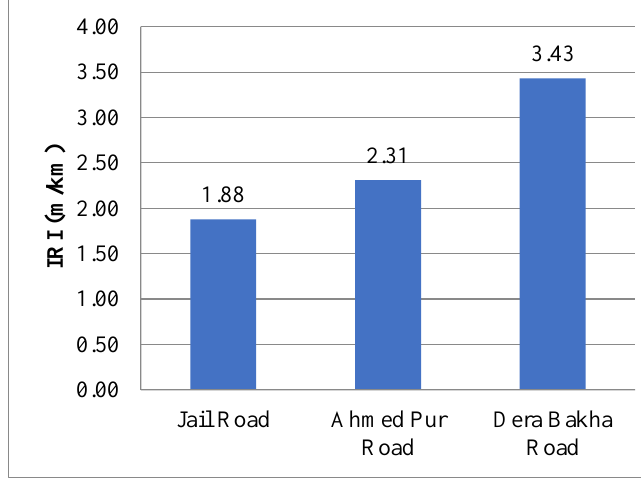
Fig. 1. Avg. IRI values (m/km) *R.D = Reduce Distance The last pavement performance parameter cracking IRI values Calculation was measured using Pavement Condition Rating (PCR) by visual examination. During visual examination of the road different types of road distresses were observed like rutting, potholes, cracks, wheel track and faulting. The severity and extent of these distresses were examined visually. PCR value ranges from 1 to 100, higher the value better the pavement condition. The calculated values of PCR are 92.7, 64.4 and 40.7 for Jail road, Ahmed-Pur road and Jhangi wala road respectively as shown in Fig. 3. The calculation of PCR values are presented in Table 3 (Annex A).